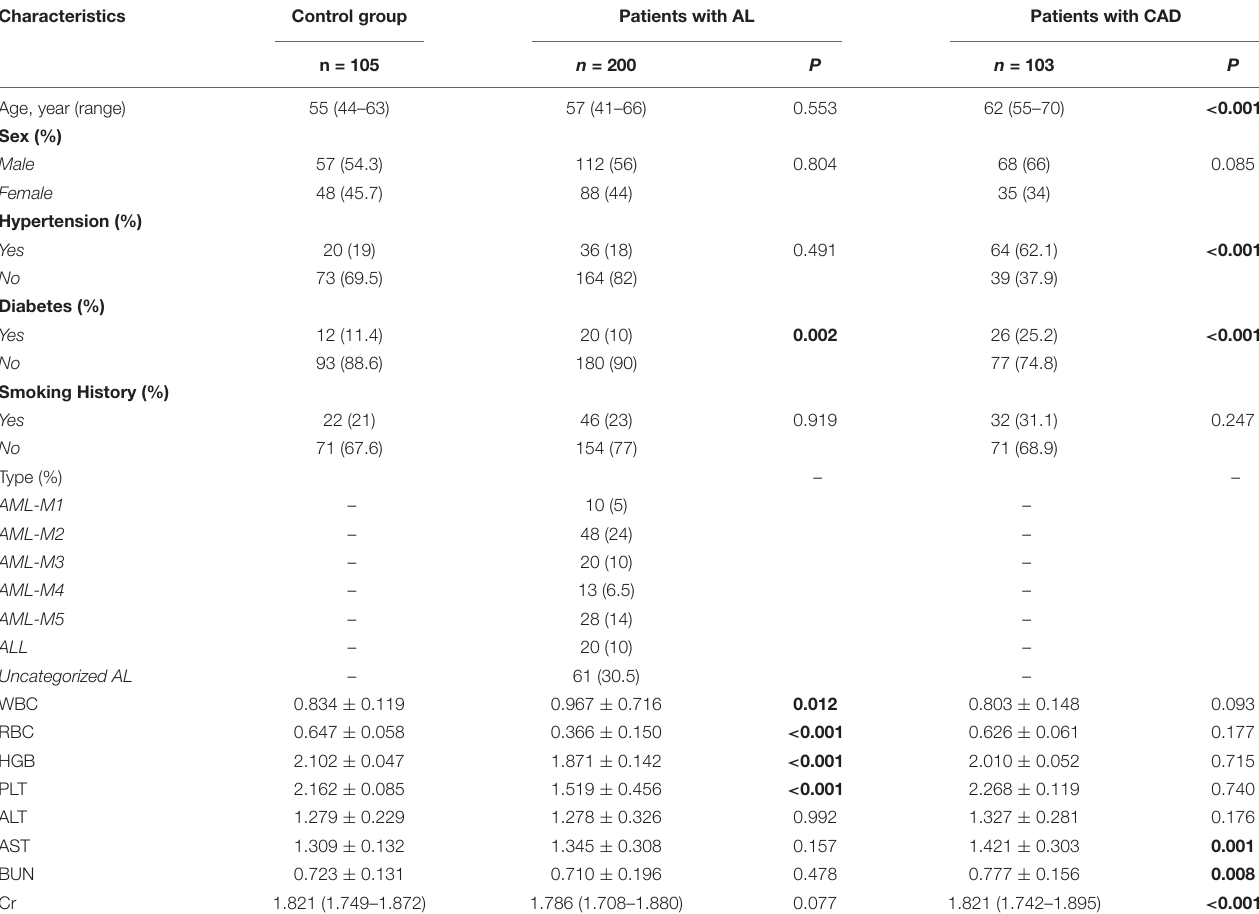
TABLE 1 | Clinical characteristics of the study